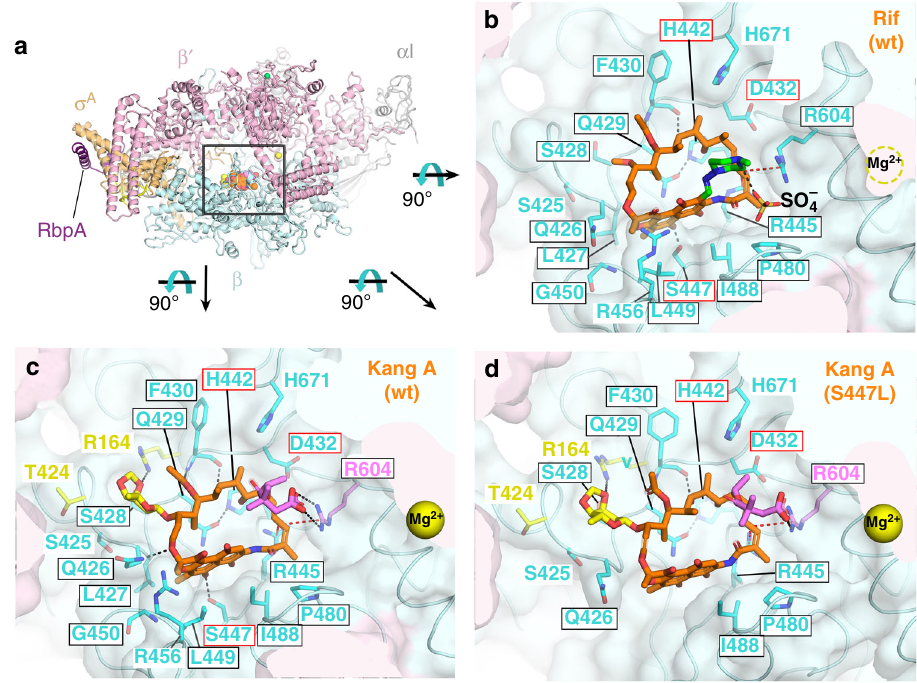
Fig. 4 Structural basis for Kang A inhibition of Rif R RNAP. a Overall view of the Msm TIC bound to Kang A. The Rif scaffold of Kang A is colored orange, K-sugar yellow, K-acid violet. wt, wild-type. The boxed region is magni fi ed in (B) (showing Rif/wt-RNAP), (C) (Kang A/wt-RNAP), and (D) (Kang A/S447L-RNAP), but the view is rotated 90° as shown. b View into the Rif binding pocket (wt-RNAP) from inside the Msm RNAP active site cleft. Carbon atoms of the Rif scaffold are colored orange, carbon atoms of the 1-methyl-piperazine moiety are colored green. The RNAP is shown as a backbone worm with a transparent molecular surface ( β , light cyan; β ′ , light pink). Density for the RNAP active site Mg 2 + was very weak so it was not modeled, but its position is denoted by a dashed yellow circle. RNAP β subunit side chains that make direct contacts with Rif are shown, labeled and colored cyan. Polar interactions are indicated by dashed lines (gray, H-bonds; red, cation- π interactions). Strong electron density near the positively charged 1-methyl- piperazine group (Supplementary Figure S26) was interpreted as a SO 4 − ion. Boxed residue labels denote residues that have been identi fi ed as conferring Rif R when substituted 45 , with red boxes denoting three residues ( Msm RNAP β D432, H442, and S447, corresponding to Mtb RNAP β D441, H451, and S456) that comprise the majority of Rif R substitutions identi fi ed from clinical isolates from tuberculosis patients. c . View into the Kang A binding pocket (wt-RNAP). Kang A is colored as in (A). The RNAP is shown as in (A) except RNAP side chains that interact with K-sugar but not Rif (R164, T424) are colored yellow, and R604, which makes a salt bridge with K-acid is colored violet. Residues that confer Rif R when substituted are denoted by colored boxes as in (B). d View into the Kang A binding pocket (S447L-RNAP). Kang A and RNAP are shown as in (C). The RNAP β subunit segment from 447 – 450 is distorted, and the loop from 451 to 465 is disordered, resulting in the loss of Kang A/RNAP contacts with β residues L427, L447, L449, G450, and